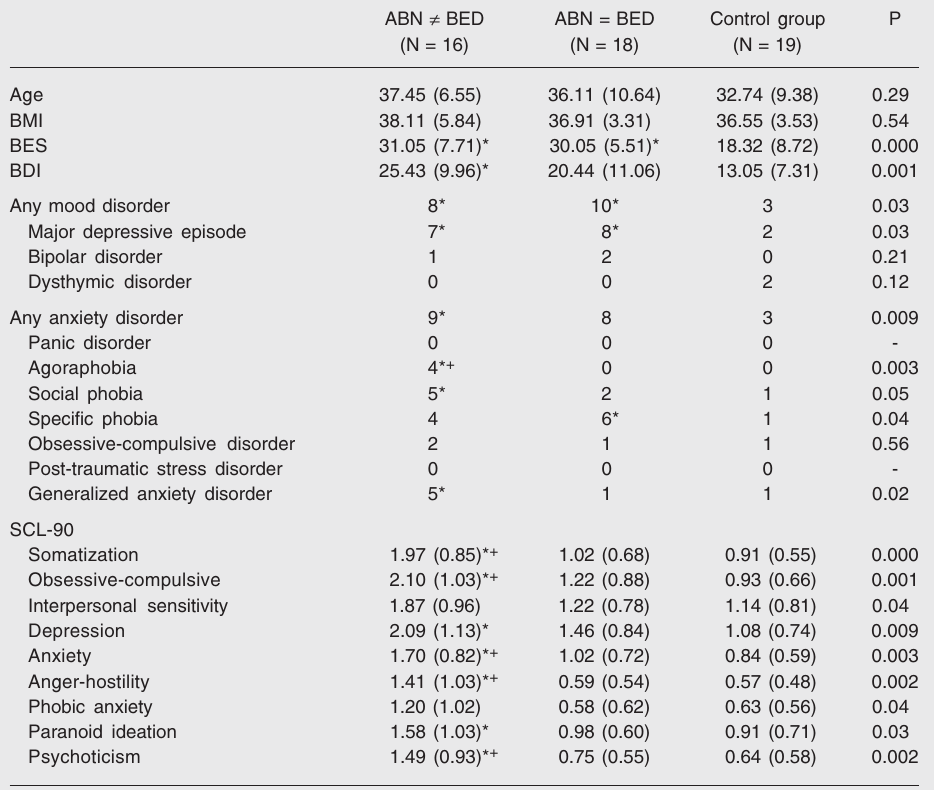
Table 1. Comparison of sociodemographic and psychiatric features of women with atypical bulimia nervosa, binge eating disorder and